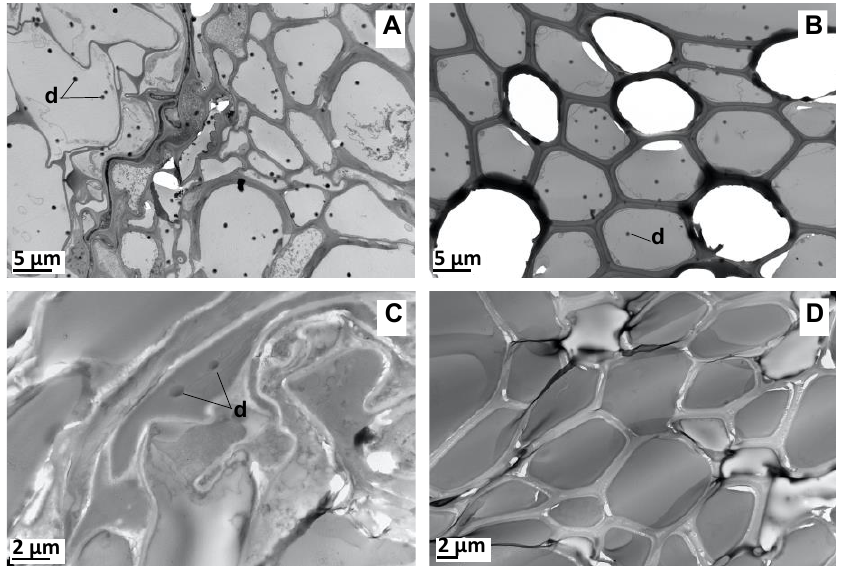
Figure 5. TEM of HPA-grown vetiver root cross-sections. ( A ) Stained section of parenchyma cells. ( B ) Stained section of woody cells. ( C ) Unstained section of parenchyma cells. ( D ) Unstained section of woody cells. d: EO droplet.